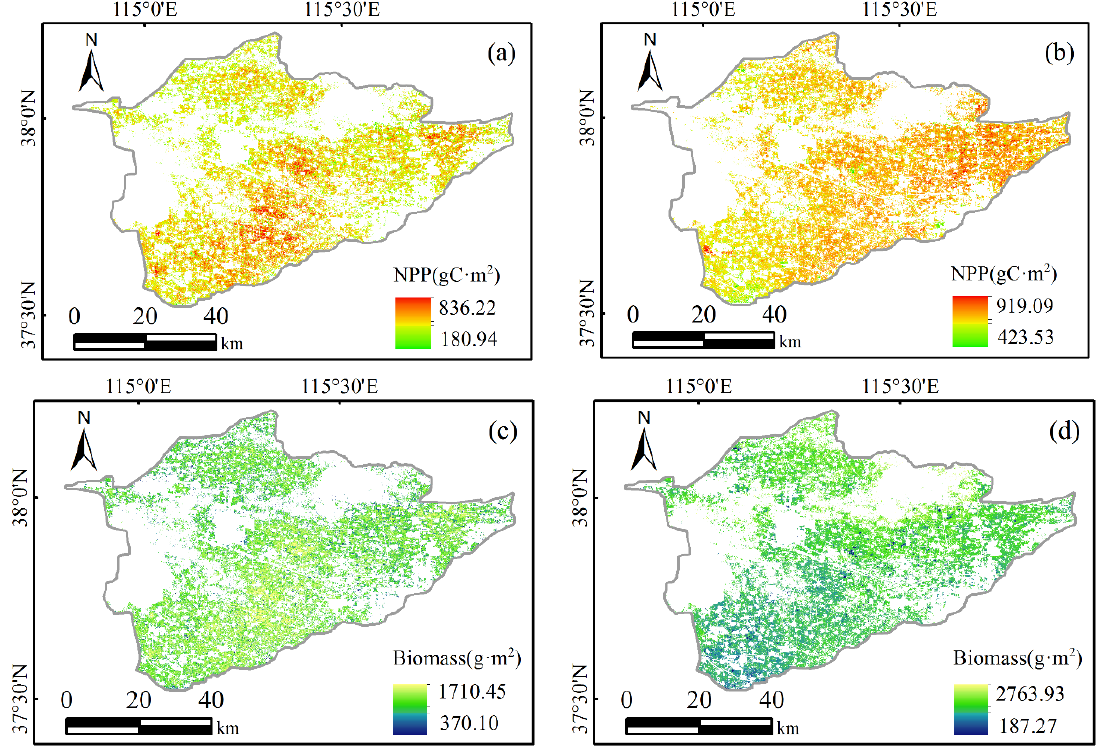
Figure 9. The spatial distribution of the accumulated aboveground NPP and biomass of the crops during the main growing season. ( a ) Cumulative NPP of winter wheat from March to May. ( b ) Cumulative biomass of summer maize from July to September.